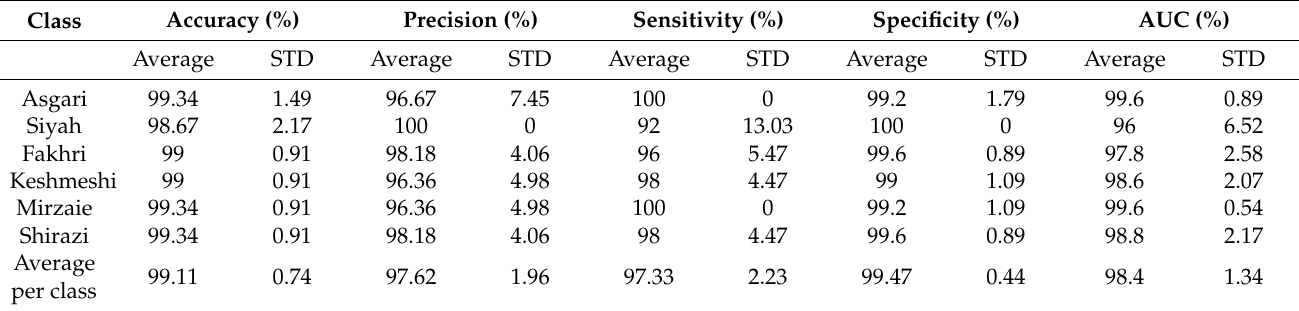
Table 3. Average statistical parameters and deviations of the selected convolutional neural network model. AUC = area under the curve.